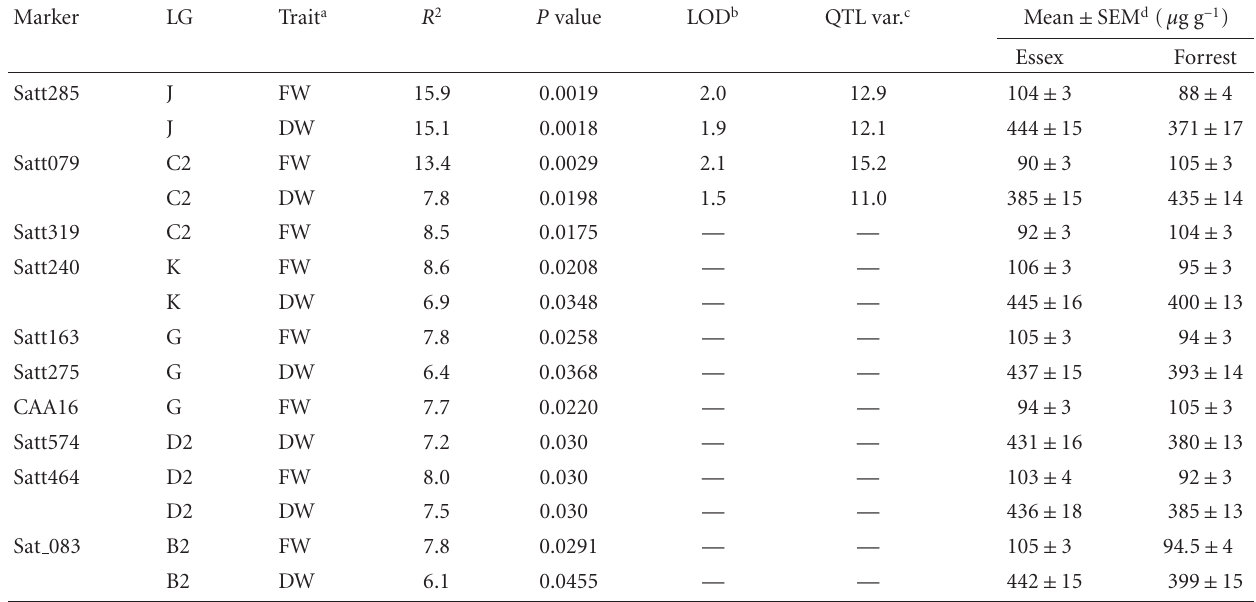
Table 2. DNA markers associated with QTLs for trigonelline biosynthesis in 70 RILs derived from the cross of Essex with Forrest.